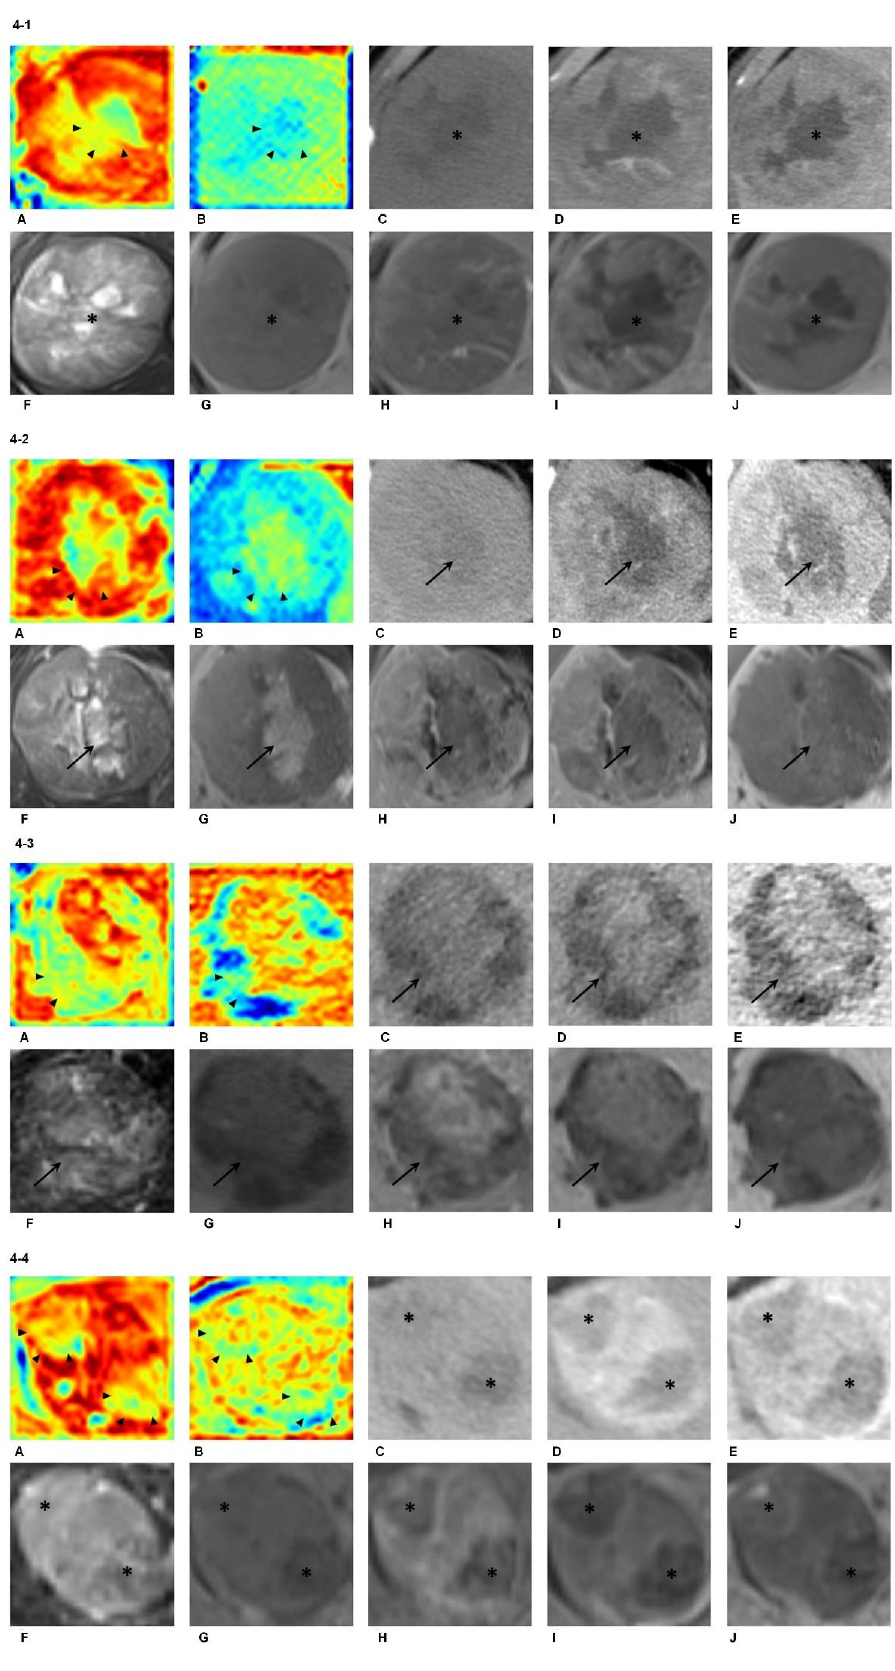
Figure 4. Attention maps derived from EOB-MRI and CE-CT. ( 4-1 ). Attention maps ( A , B ), contrast-enhanced CT (CE-CT; C – E ) and gadoxetic acid-MRI (EOB-MRI; F – J ) of a 43-year-old male patient with hepatocellular carcinoma (HCC).